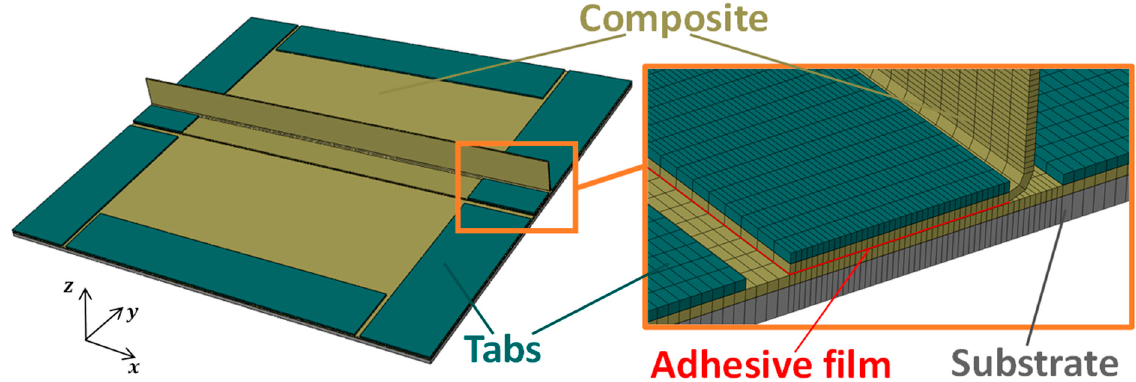
Figure 7. Geometrical FE modelling of the parts: composite skin, composite stiffener, epoxy adhesive film, aluminium tabs, aluminium substrate.